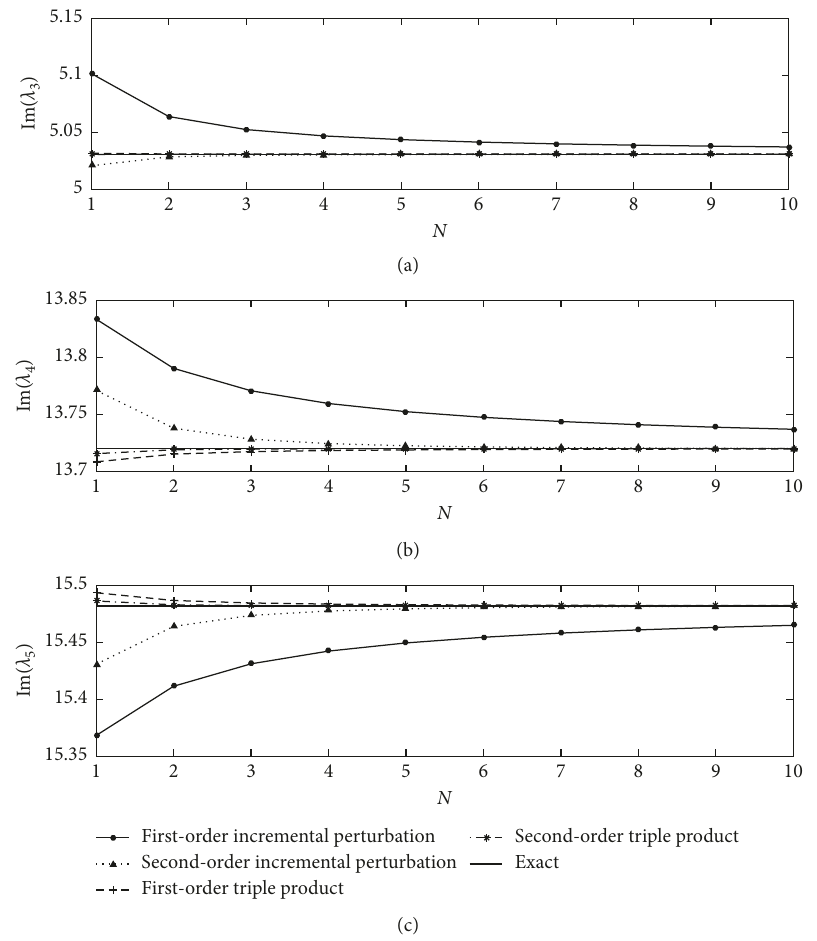
Figure 15: The imaginary parts of the approximate eigenvalues of the whirling beam as a function of N for σ Table 9: The real parts of the exact and approximate natural frequencies for the perturbed whirling beam at N Exact